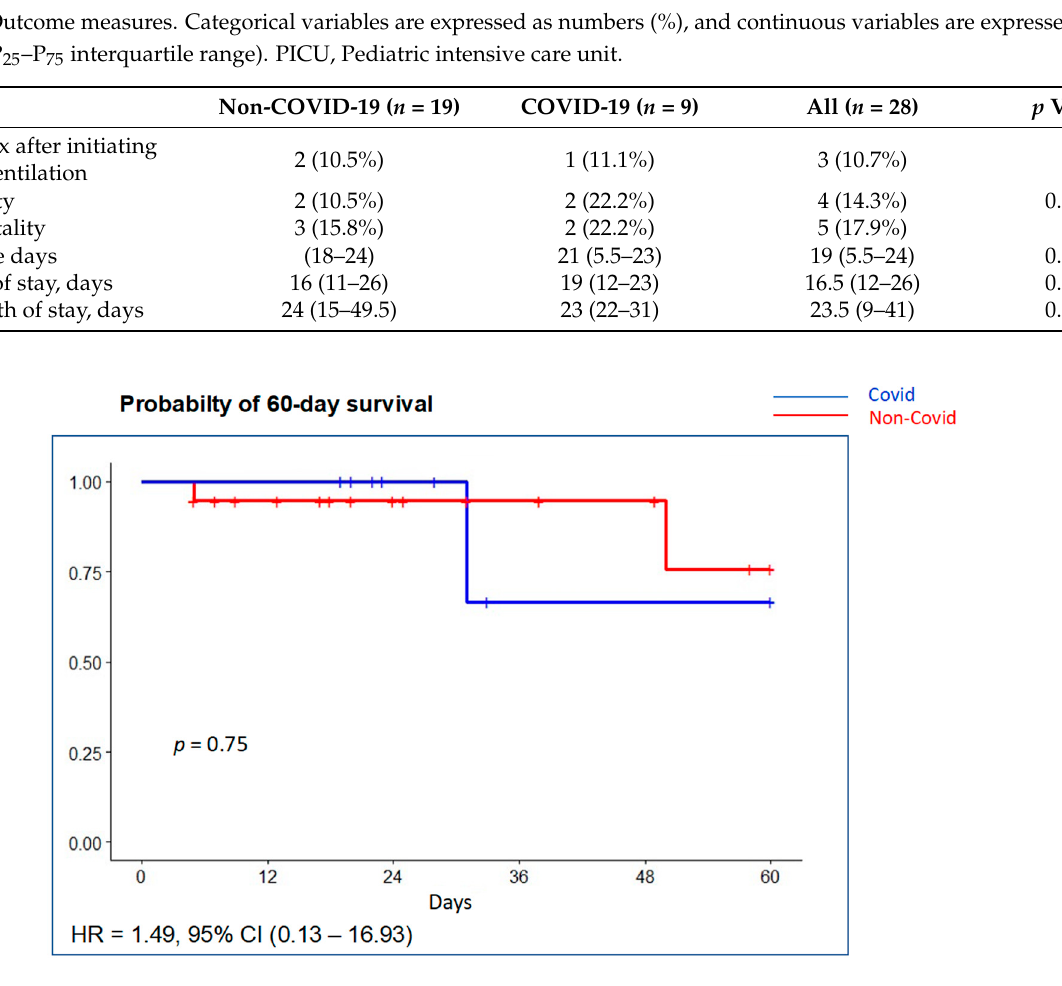
Figure 4. Probability of survival at 60 days using Kaplan–Meier curves with univariable Cox regression. There was no significant difference in survival between the COVID-19 group (blue line) compared with the non-COVID-19 group (red